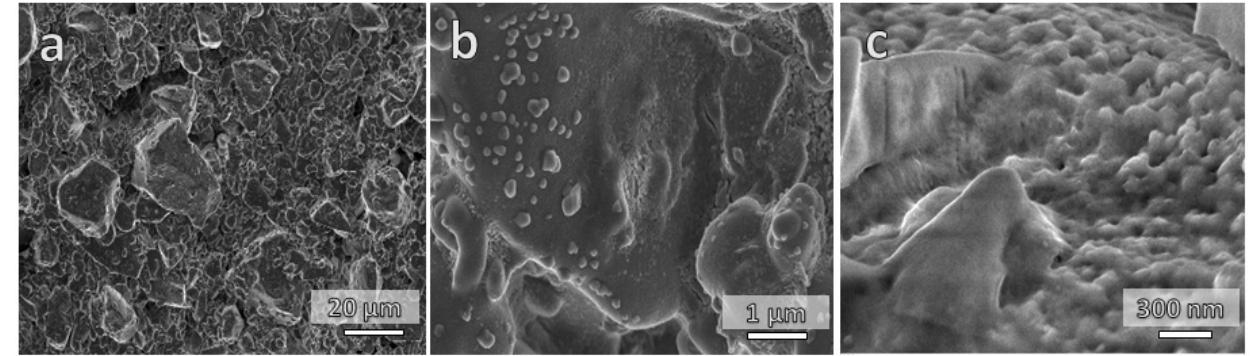
Figure 6. Microstructural details of gyroid scaffolds: ( a ) fired at 680 ◦ C; ( b ) the recycled gyroid fired at 680 ◦ C; and ( c ) the recycled gyroid fired at 730 ◦